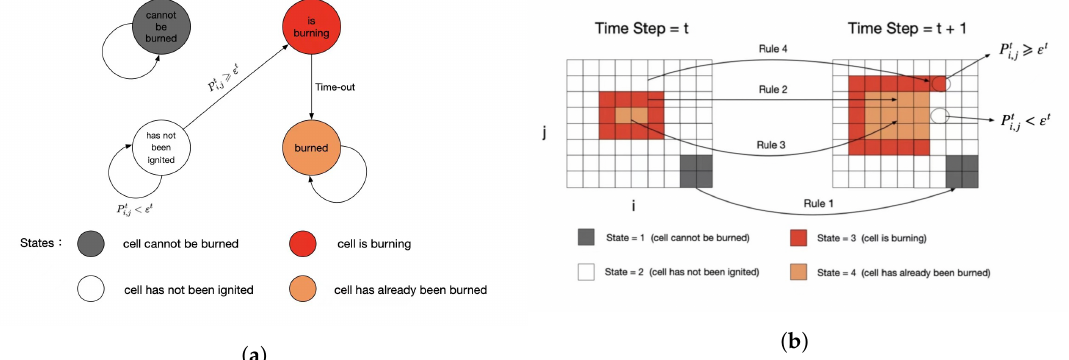
Figure 2. The principle of cellular automata: ( a ) state transition and ( b ) example of